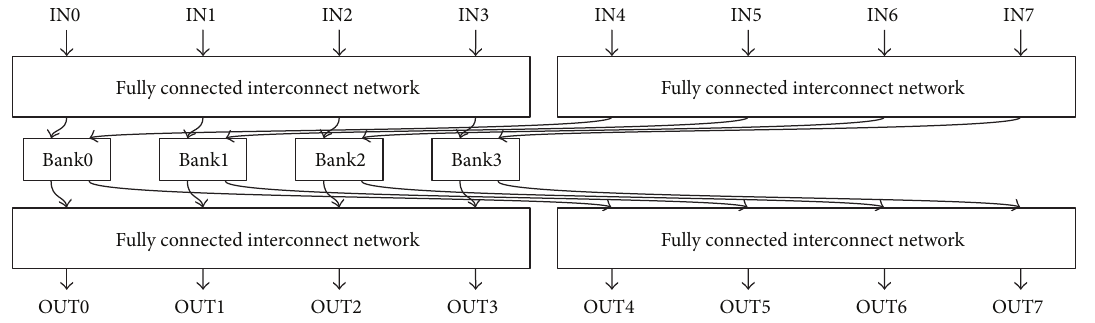
Figure 17: A banked multiport memory using single-port RAM blocks can be modified to use dual-port RAM blocks by replicating the design and sharing RAM